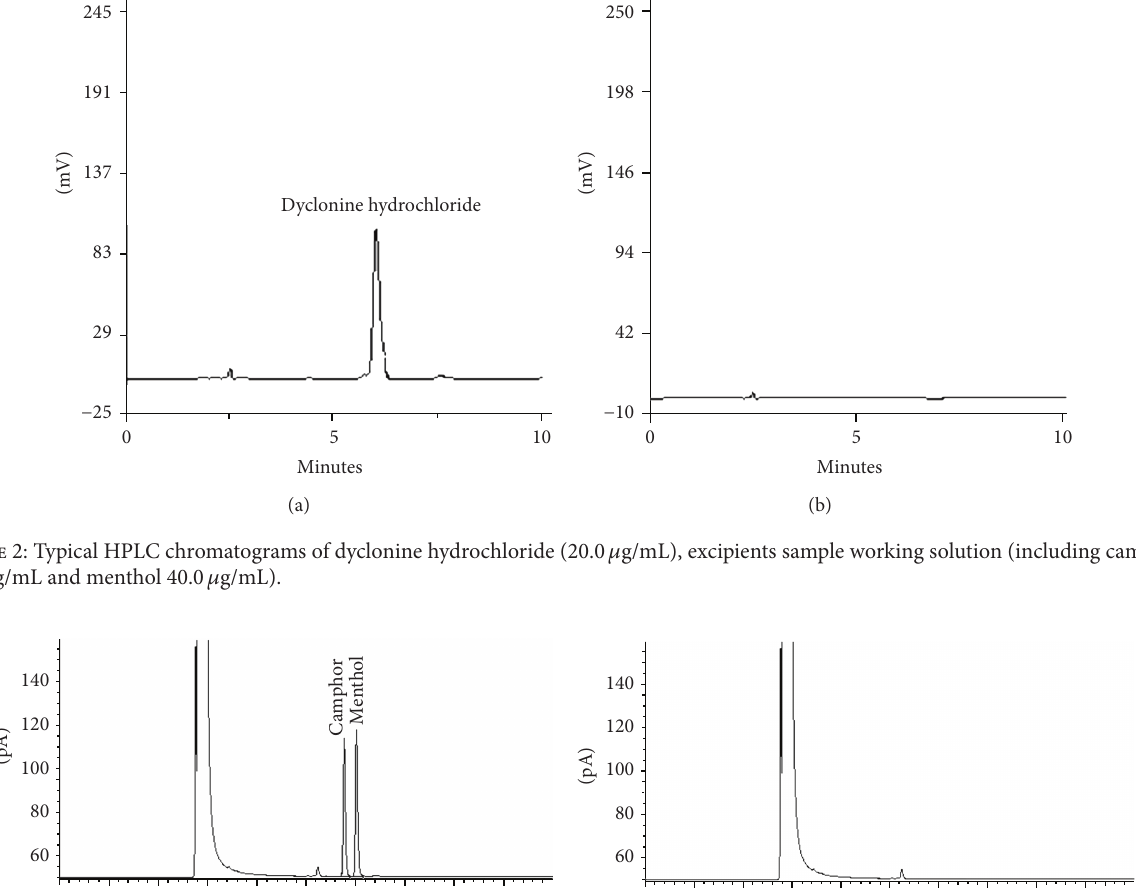
F 3: Typical GC chromatograms of camphor